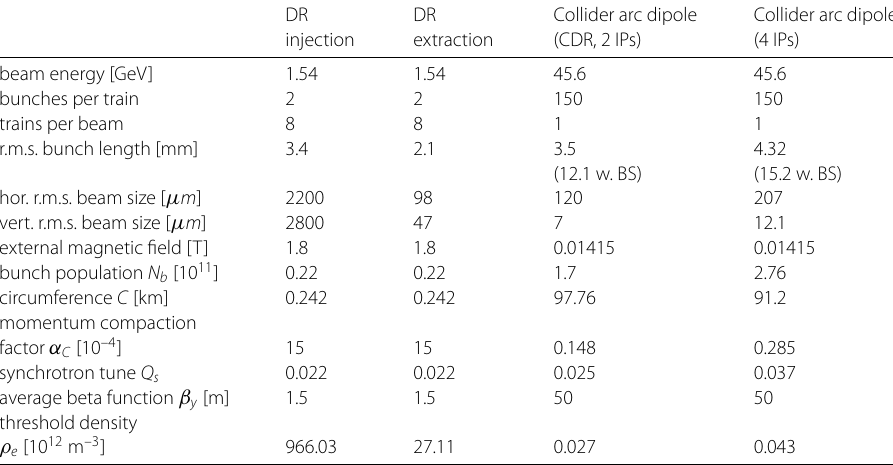
Table 1 Parameters employed for the simulations of the damping ring [4] and collider arcs for the CDR parameters with 2 Interaction Points (IPs) [1] and the new baseline with 4 IPs [24]. Collider bunch length is shown as due to synchrotron radiation and including the effect of beamstrahlung (“BS”, in parentheses) DR